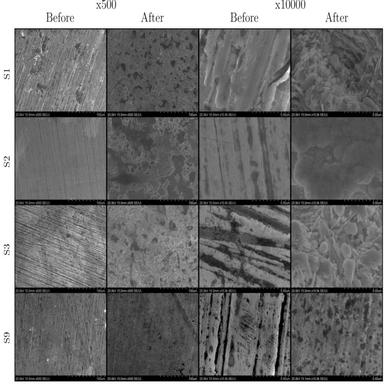
SEM images before and after testing for the aluminum bronze. The left two columns are at a x500 magnification and the right two at a x10000 magnification. The porosity of the sample is easily seen in the SEM images after lithium exposure. However, chemical analysis is needed to understand the compounds in each region of the porous media. Samples S1-S3 were exposed to lithium and sample S9 was only heat-treated.